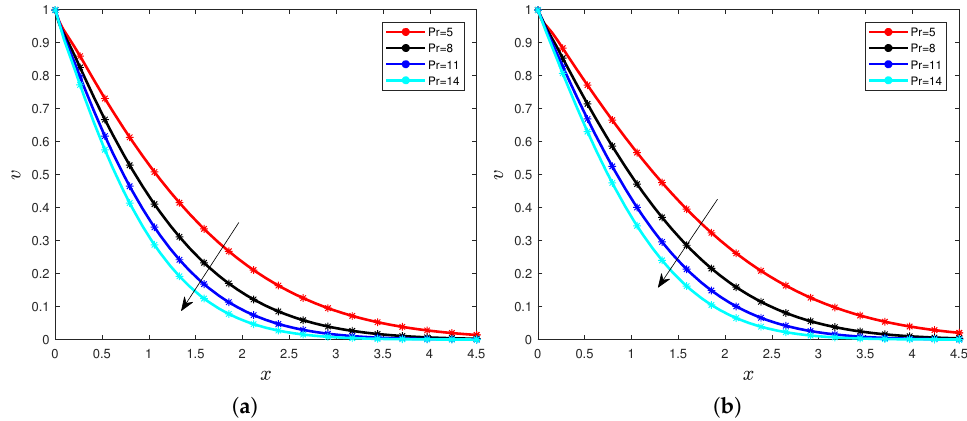
Figure 10. Temperature for different values of the Prandtl number with α = 0.85 ( a ) and α = 0.95 ( b ).